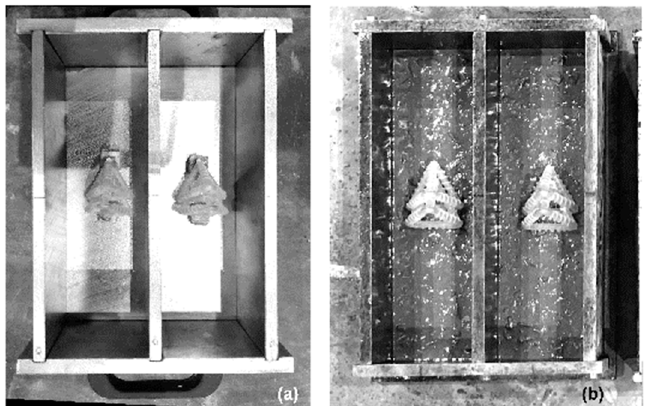
Figure 3. TETs disposition within the concrete beam ( a ) 2TETs placed via 10 mm spacer; ( b ) specimens filled to 10 mm from the base of the mould.